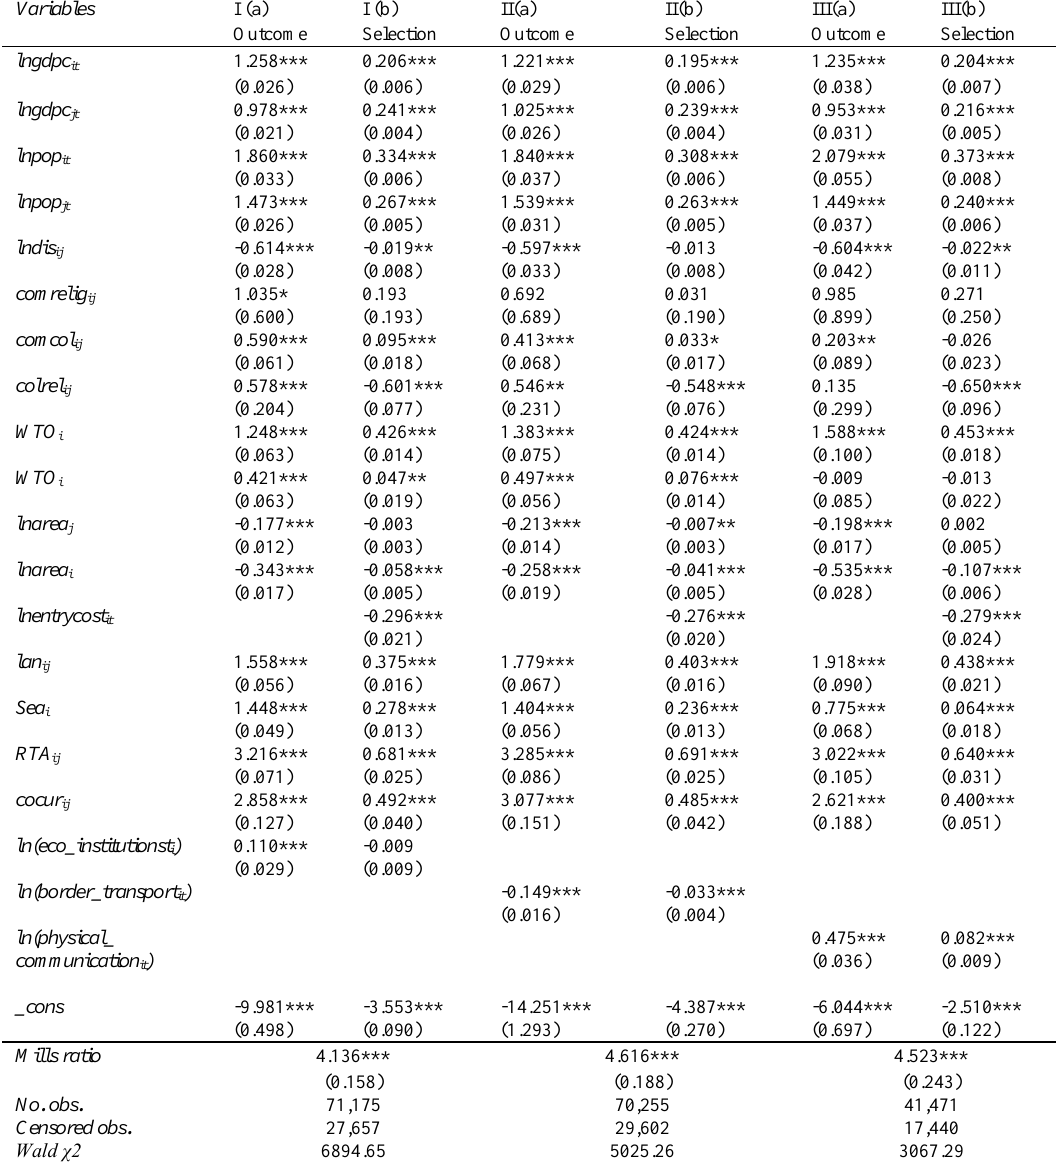
Table 1 : The impacts of border and transport efficiency, quality of institutions, physical and communication infrastructure on trade flow of African countries (twostep